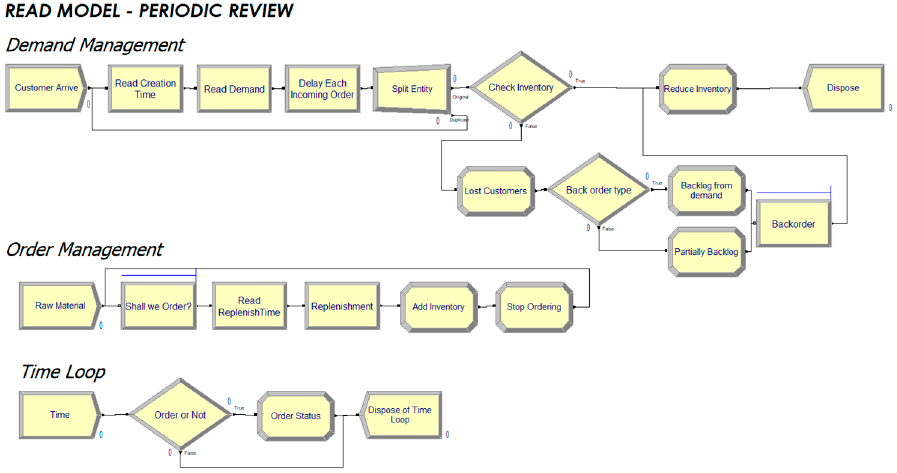
Figure 7. Read model of periodic review policy.